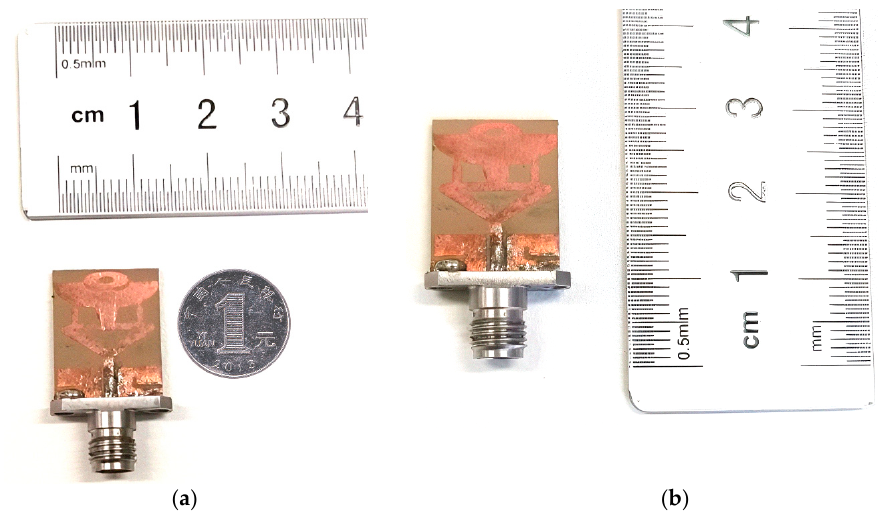
Figure 8. Fabricated antenna design model ( a ) antenna width, and ( b ) proposed antenna length.